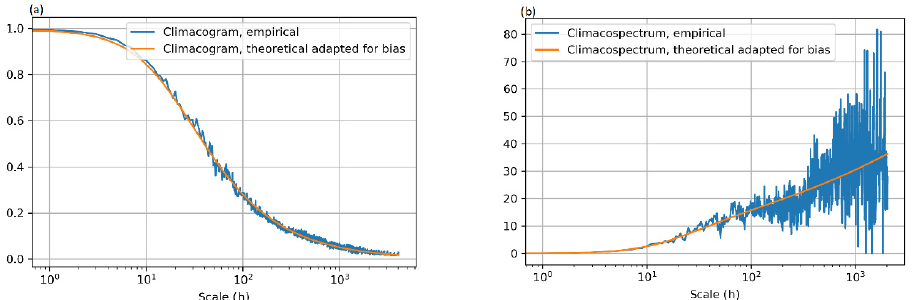
Figure 4. ( a ) Empirical and theoretical (Filtered Hurst Kolmogorov model) climacogram, and ( b ) Empirical and theoretical (Filtered Hurst Kolmogorov model) climacospectrum of the hourly streamflow of the Monocacy River.